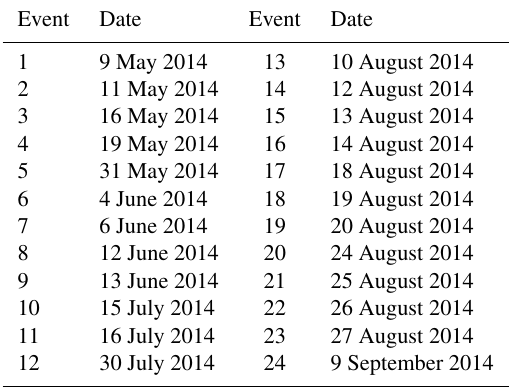
Table 2. Summary of the studied events.